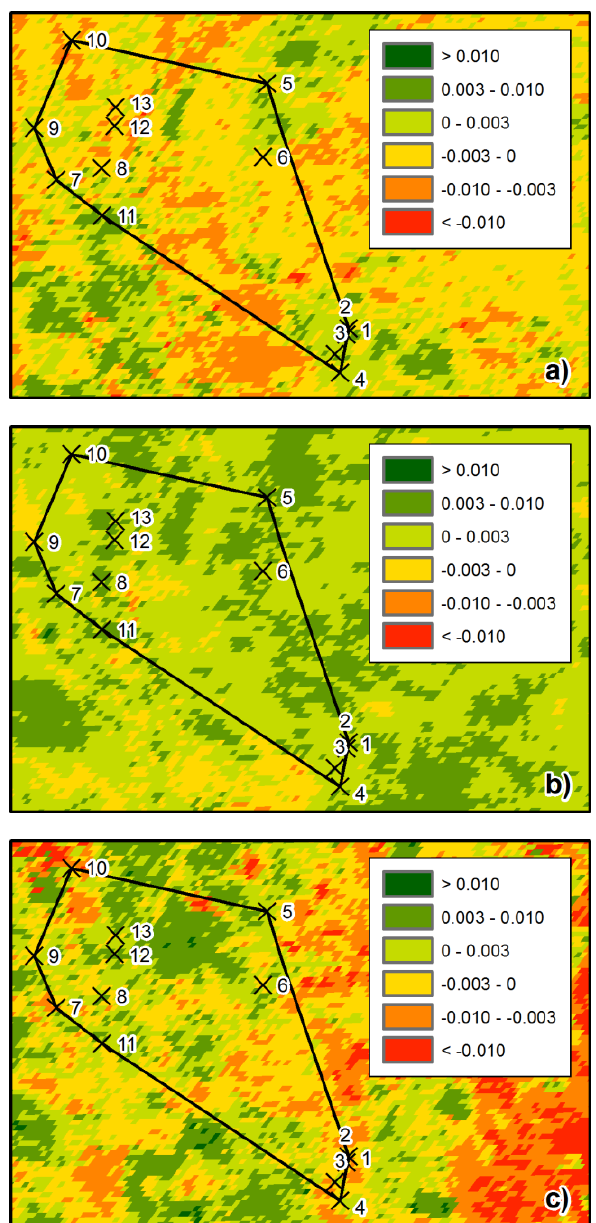
Figure 5. Spatial distribution of the vegetation index trends on the ground test area in the spring (a), summer (b) and autumn